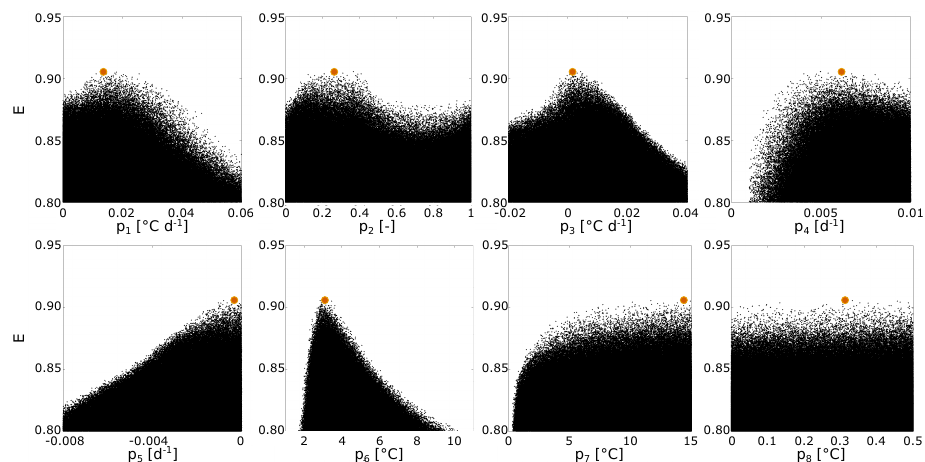
Fig. 4. Dotty plots of efficiency indexes ( E ) for the eight-parameter model during the calibration period 1985–2002 (NDBC simulation). Fig. 4. Dottyplots of efficiency indexes ( E )for the 8-parameters model during the calibrationperiod 1985-2002 (NDBCsimulation). Highest Highest efficiency is presented with an orange efficiency is presented with an orange dot.